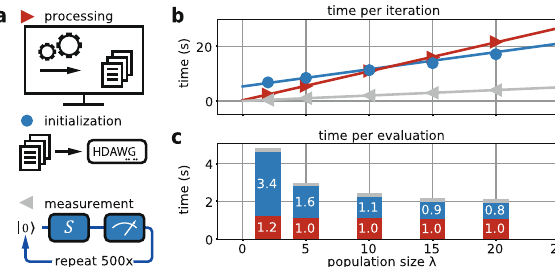
Fig. 5 Runtime distribution of typical experiments. a Experimental runtime consisting of processing the pulse sequences (red right triangles), initializing the setup (blue circles) and measuring the cost function (gray left triangles). b Time per iteration of CMA-ES split into those three categories. In one iteration the cost function of each candidate solution in the whole population of size λ is measured. Error bars are smaller than the size of the data points. c Time per evaluation, as a function of population size. Each candidate solution in a given population requires one evaluation. As the population size increase the experimental runtime to evaluate a full iteration increases and the average time to evaluate a candidate solution